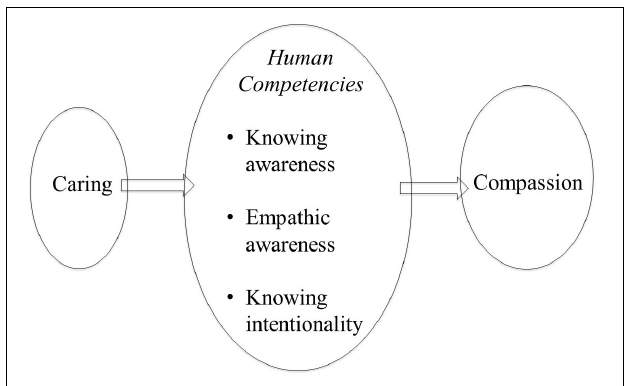
FIGURE 2 | From caring to compassion: from Gilbert (2018). Living like crazy with permission Annwyn